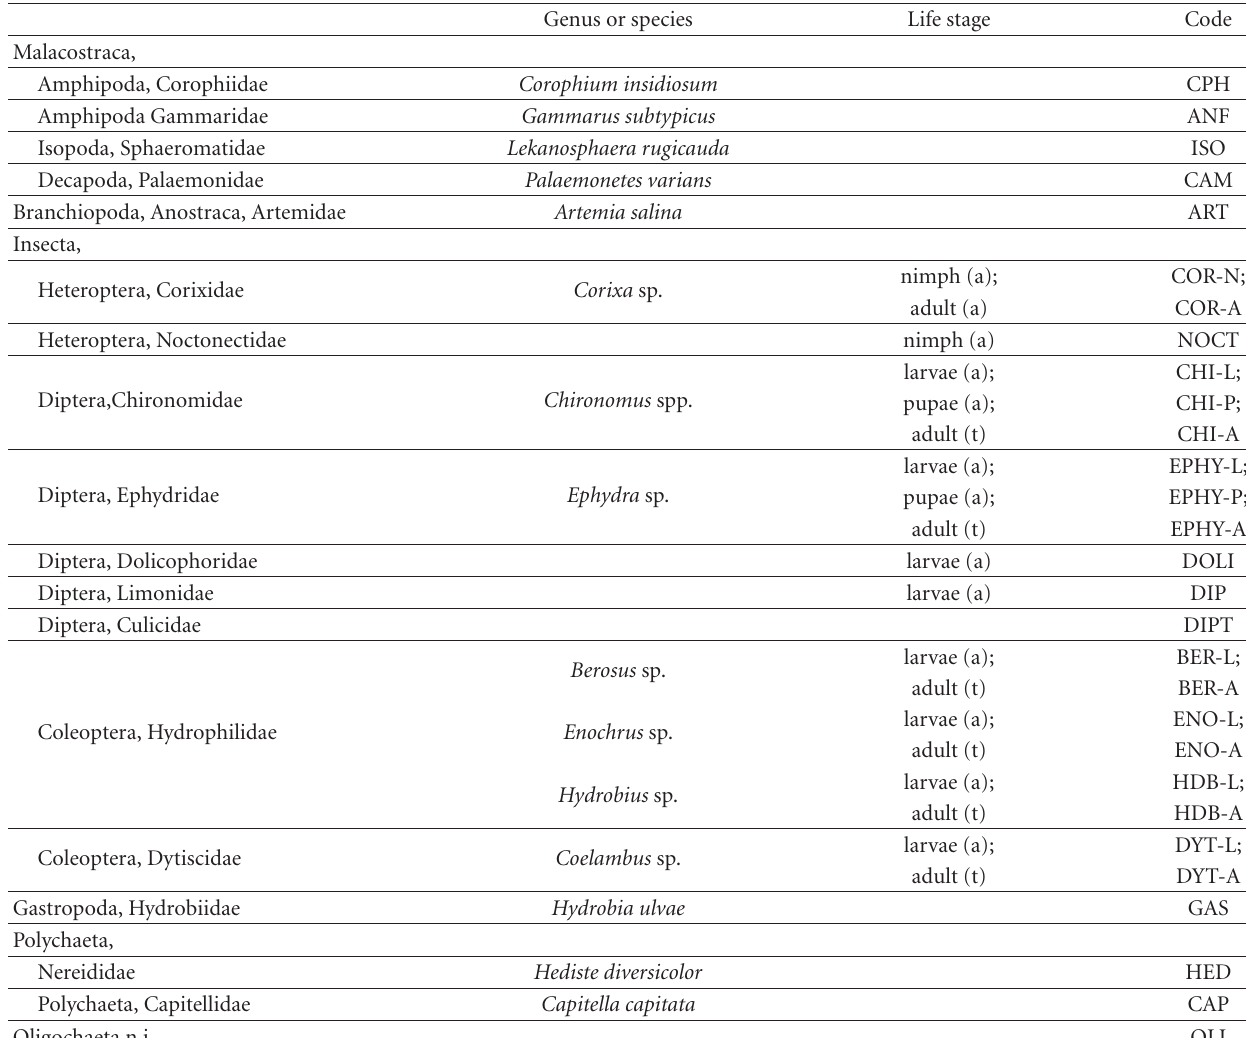
Table 2: Taxonomic groups in macroinvertebrate